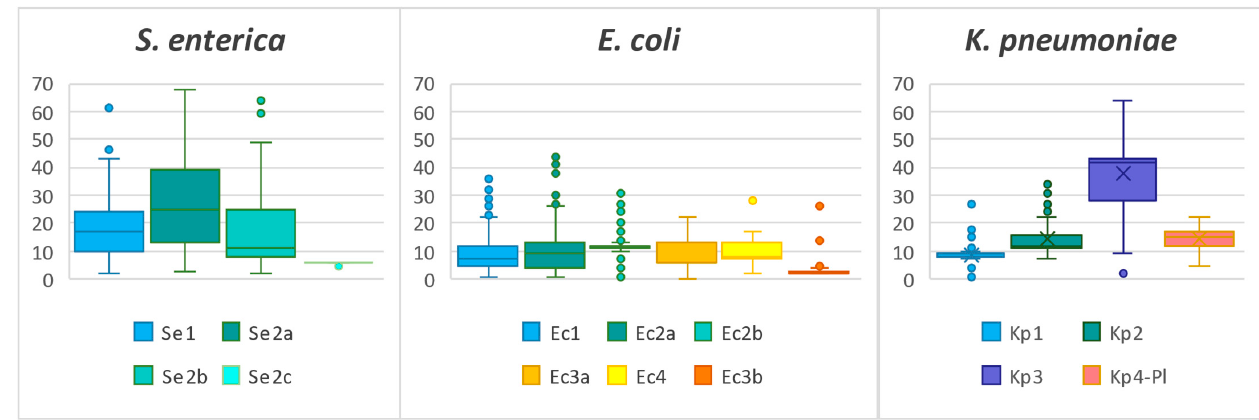
Figure 4. Distribution of the number of repeat/spacer units for each locus. The Se2a locus contains an outlier of 124 units that is not shown.